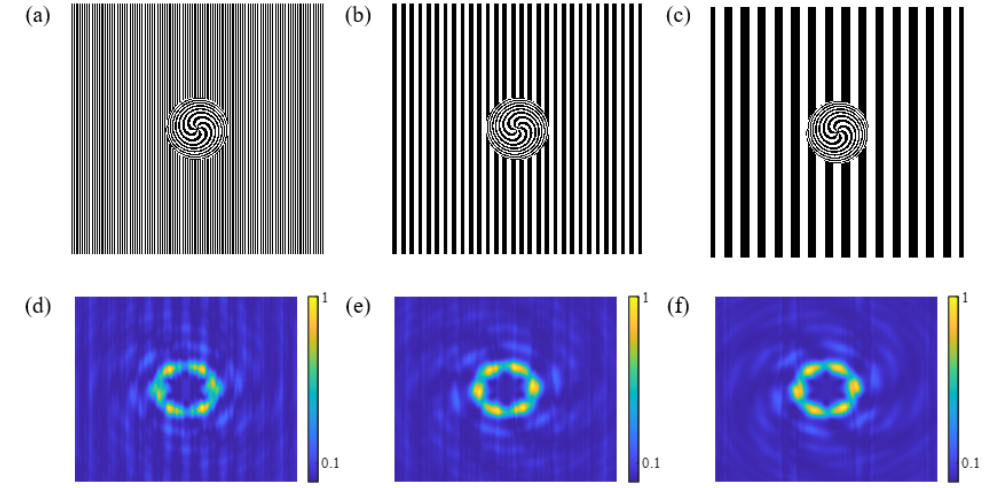
Figure 8. Schematic diagrams of the CSZPG with the parameter of ( a ) d = 100 µ m, ( b ) d = 400 µ m and ( c ) d = 800 µ m. ( d – f ) show the corresponding normalized diffraction patterns for ( a – c ), respectively.